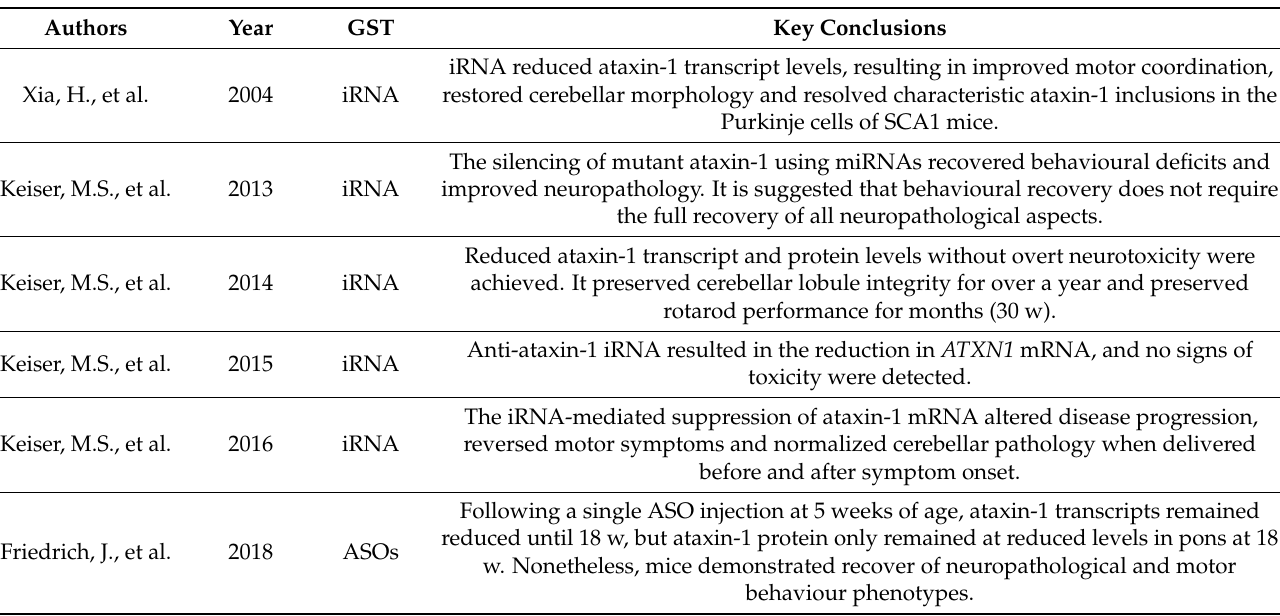
Table 2. Key conclusions from data extraction sheet—SCA1